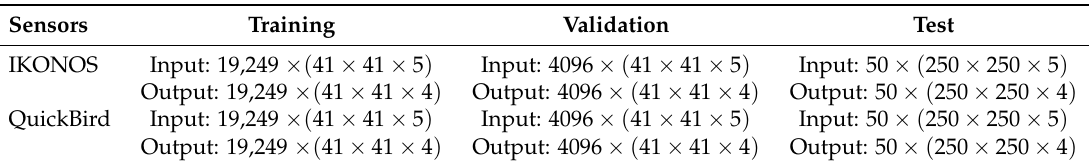
Table 1. Experimental